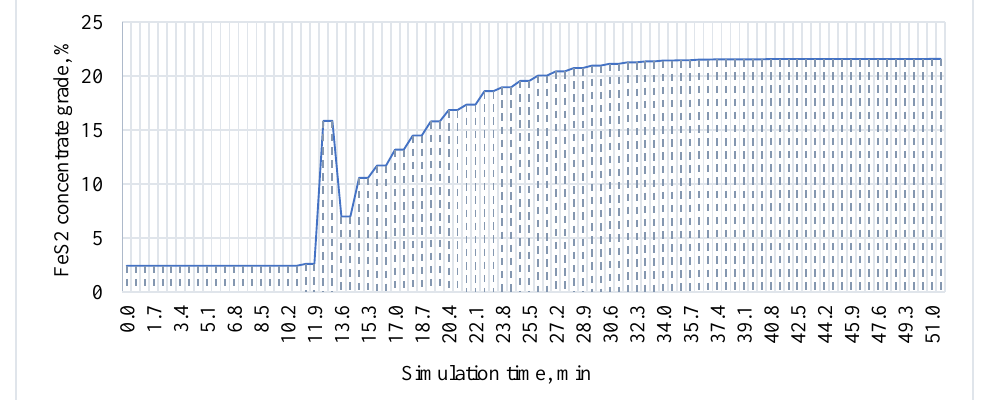
Figure 7. FeS 2 concentrate recovery.